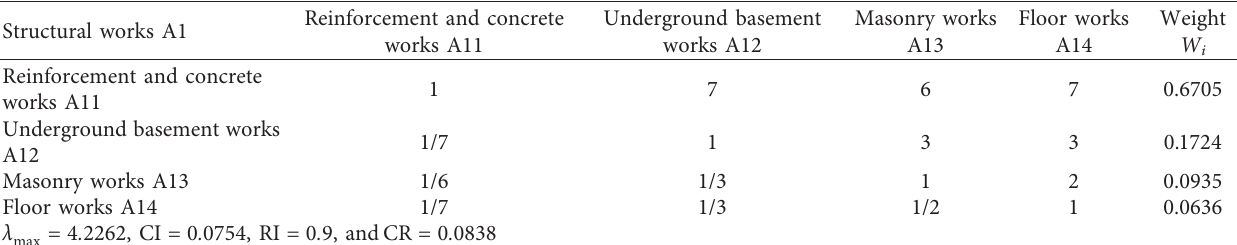
Table 5: The weight calculation matrix for structural works